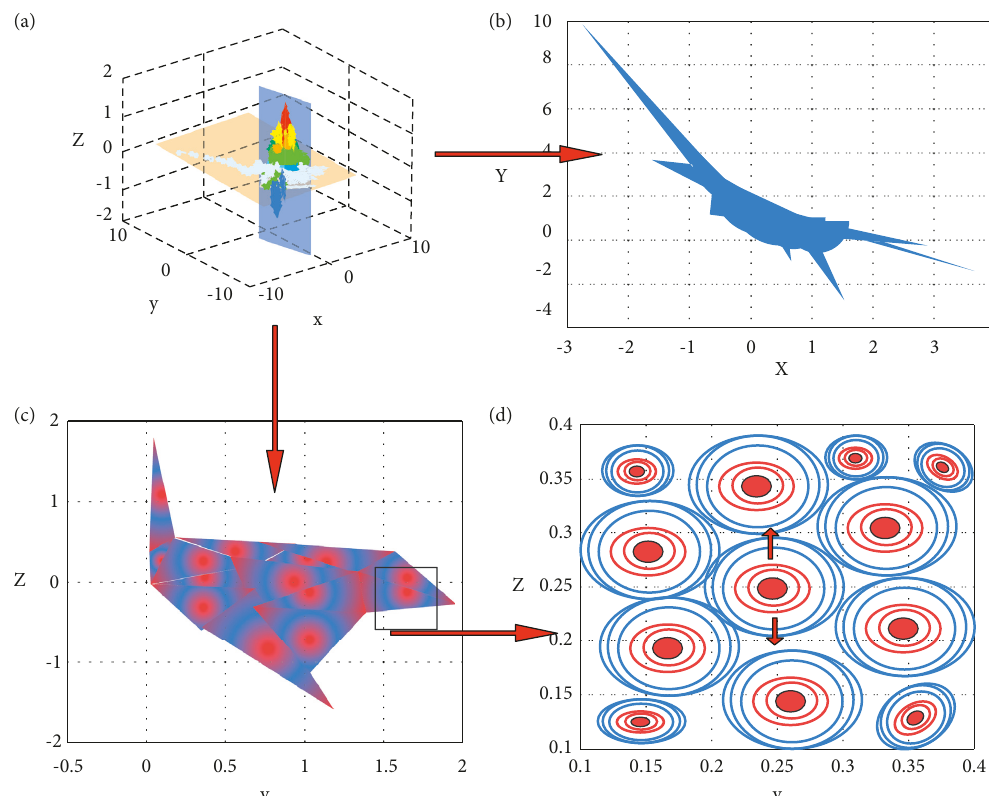
� 0; (c) 2D-filled slice K(F) with 0